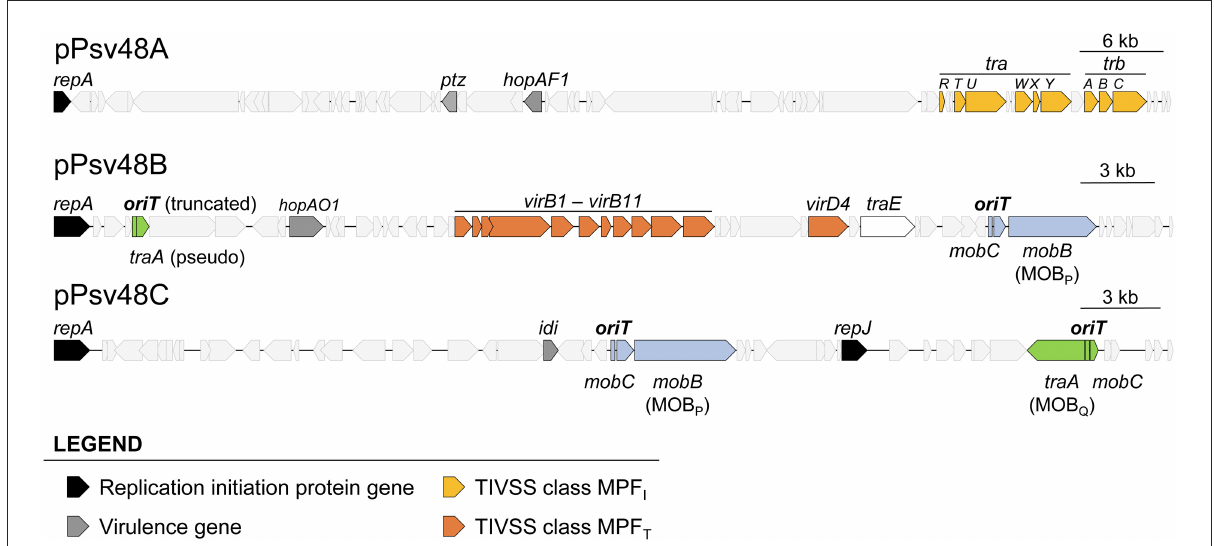
FIGURE1 Relevant genes in the three virulence plasmids of Pseudomonas syringae pv. savastanoi NCPPB3335. Location and extent of genes involved in replication, virulence, synthesis of type IV secretion systems, and relaxases and associated RAPs. The location and extent of the origin of transfer associated to the traA genes is speculative and based on other members of the MOB Q family